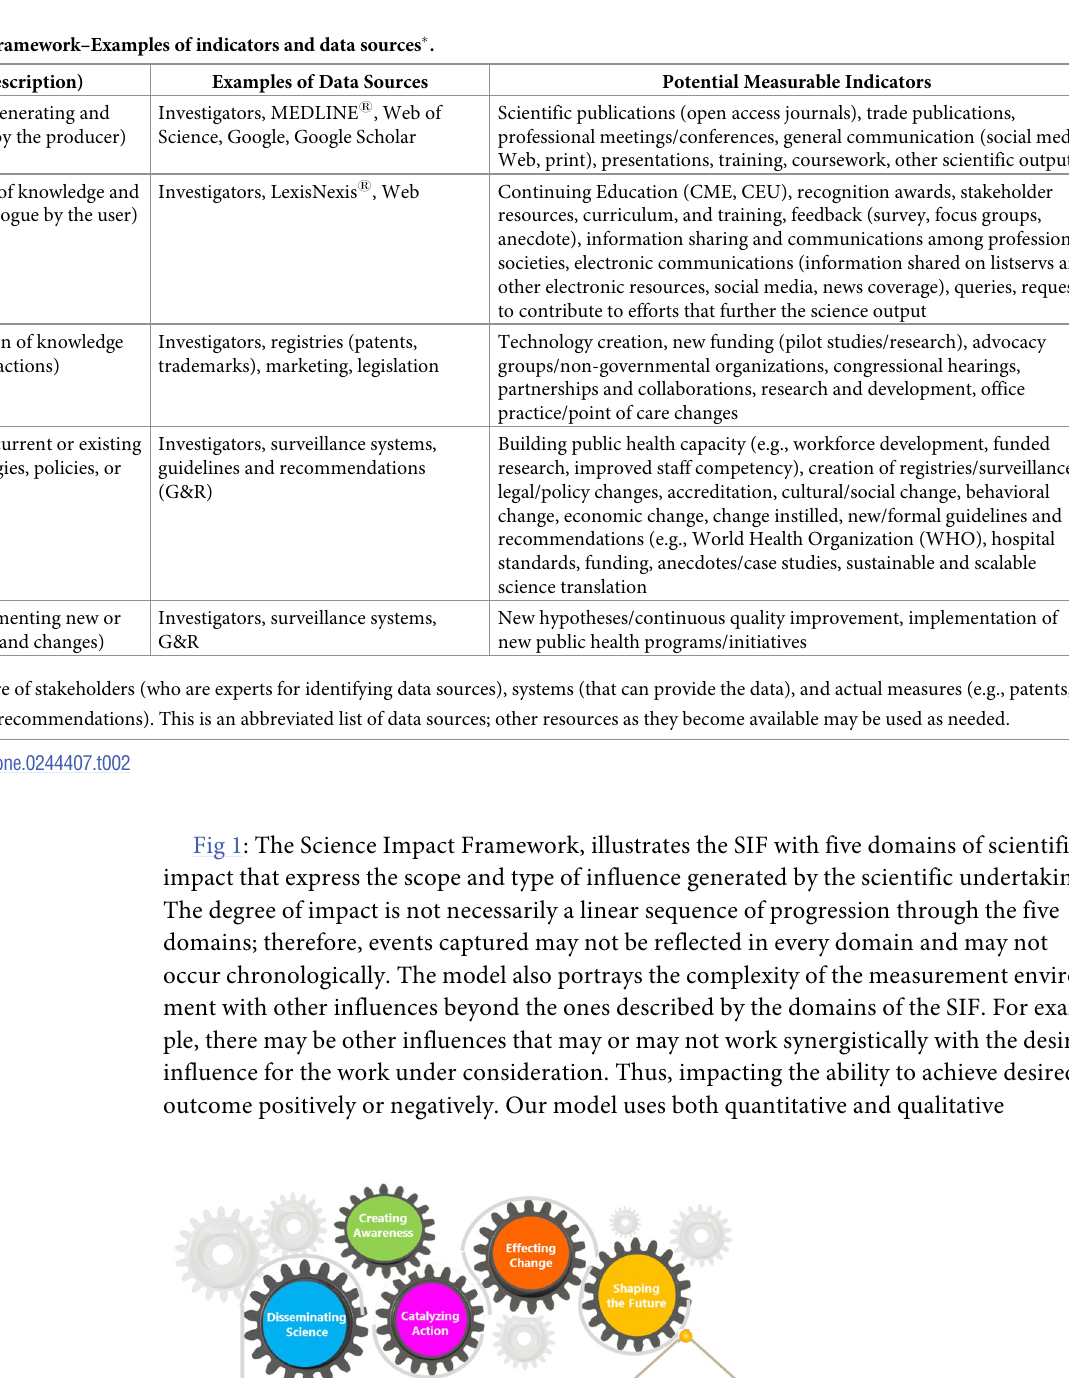
Fig 1. The science impact framework. Health outcomes are the ultimate goals, driven by the 5 domains of influence as shown in Table 1. Health outcomes, for example include positive effects on prevalence and incidence (e.g., frequency of outbreaks, trends); reduction in morbidity and mortality; increased life expectancy; and increased quality of life